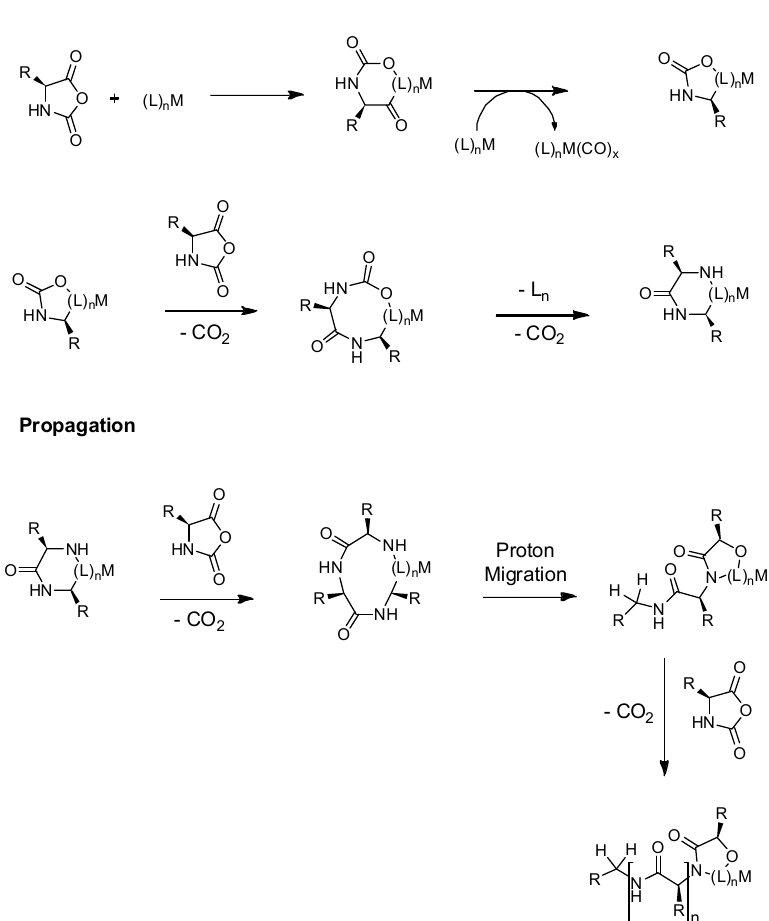
Figure 12. Propagation Reactions of the Mechanism for the Polymerization of NCAs with bipyNi (COD) (bipy) 2,2-bipyridyl, (COD 1,5-cyclooctadiene) or (PMe 3 ) 4 Co complexes proposed by Deming et al.